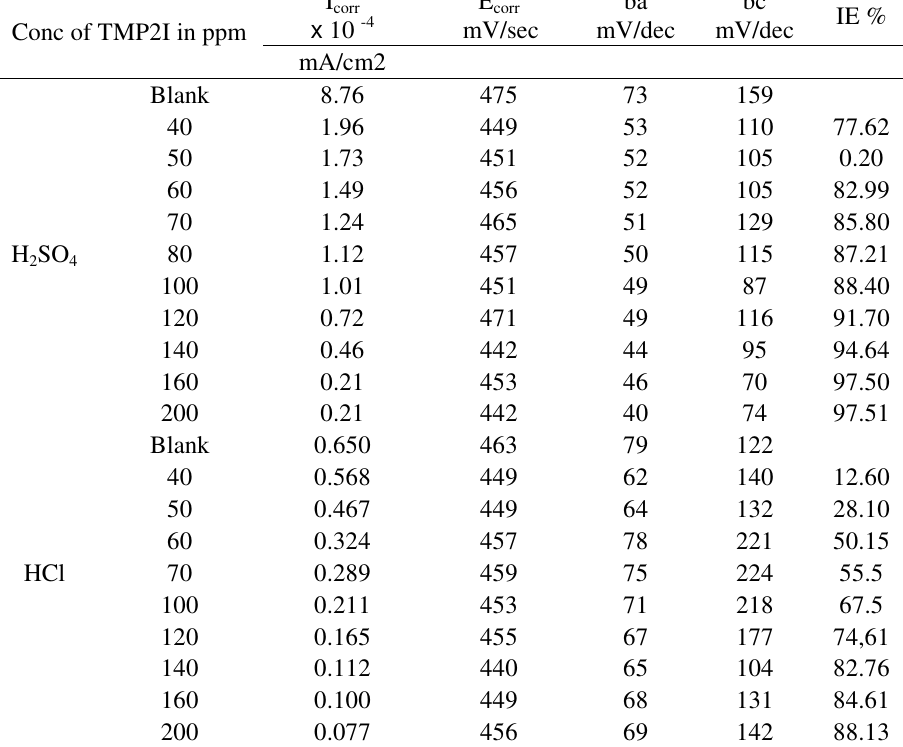
Figure 4. Polarisation curves for mild steel for mild steel in H Table 2. Results of polarisation studies of mild steel in the presence of TMP2I in H and